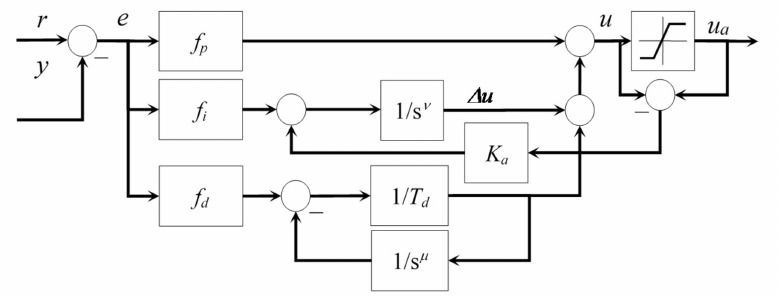
Figure 10. Fractional order nonlinear PID controller with back-calculation anti-windup